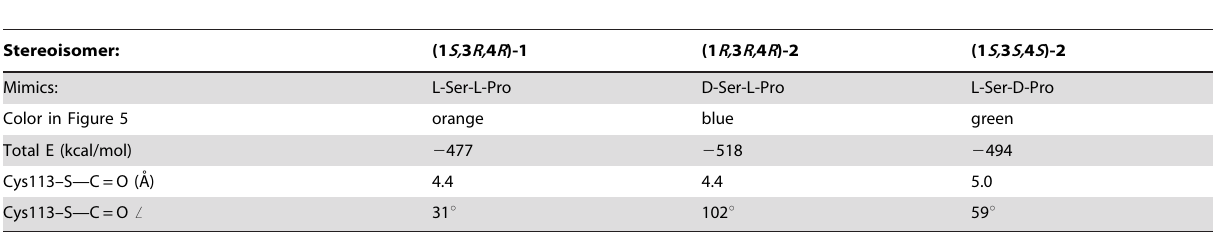
Table 1. Comparison of cyclohexyl ketone inhibitor-Pin1 complex molecular